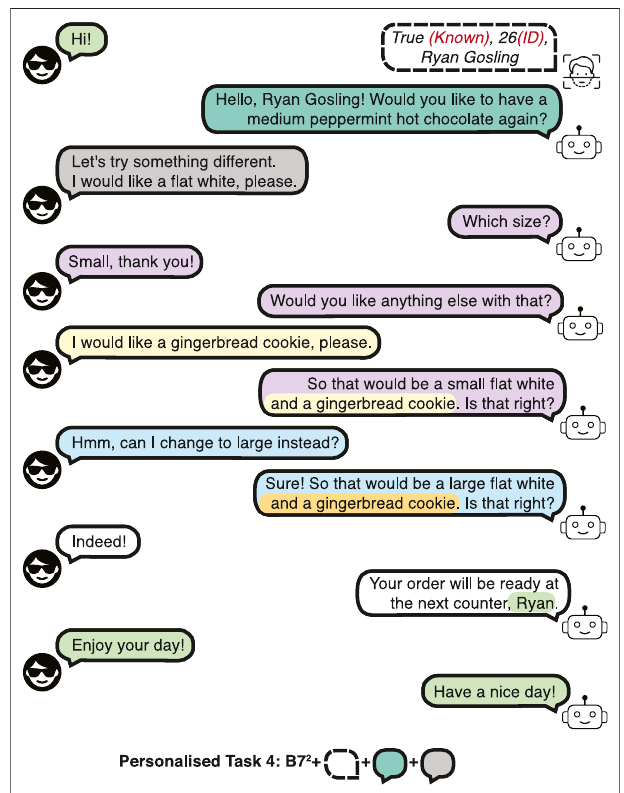
FIGURE5| AdialogueexampleinthePersonalisedBaristaDatasetTask 4 (changes to